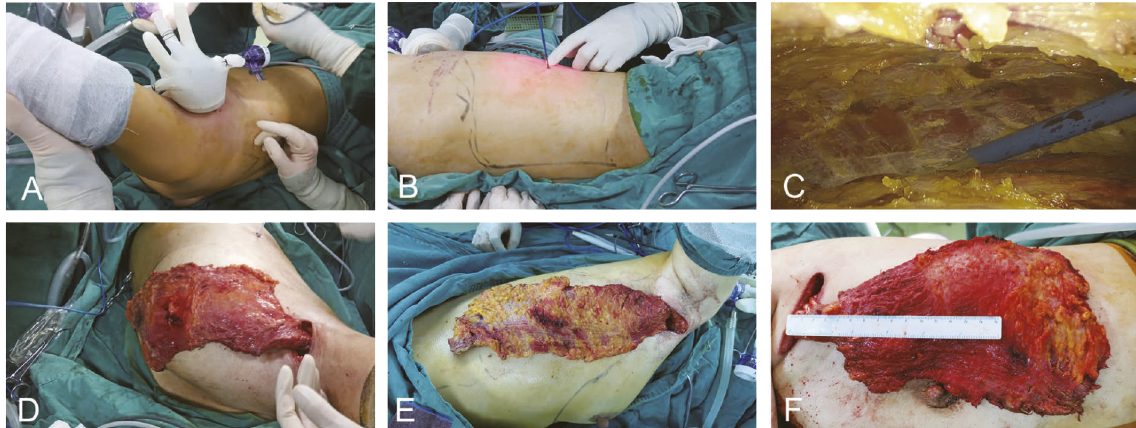
Figure 2: LDMF harvesting. (a) Self-made access with an 80mm disposable wound protector wrapped by the opening end of one sterile surgical glove of the right hand ( # 7.5); (b-c) insert the electric knife through “Huaxi hole 2”; (d–f) different sizes of harvested LD (the surrounding fat fascia tissue of LDMF was taken together for some patients to ensure that there was enough tissue volume to meet the needs of breast